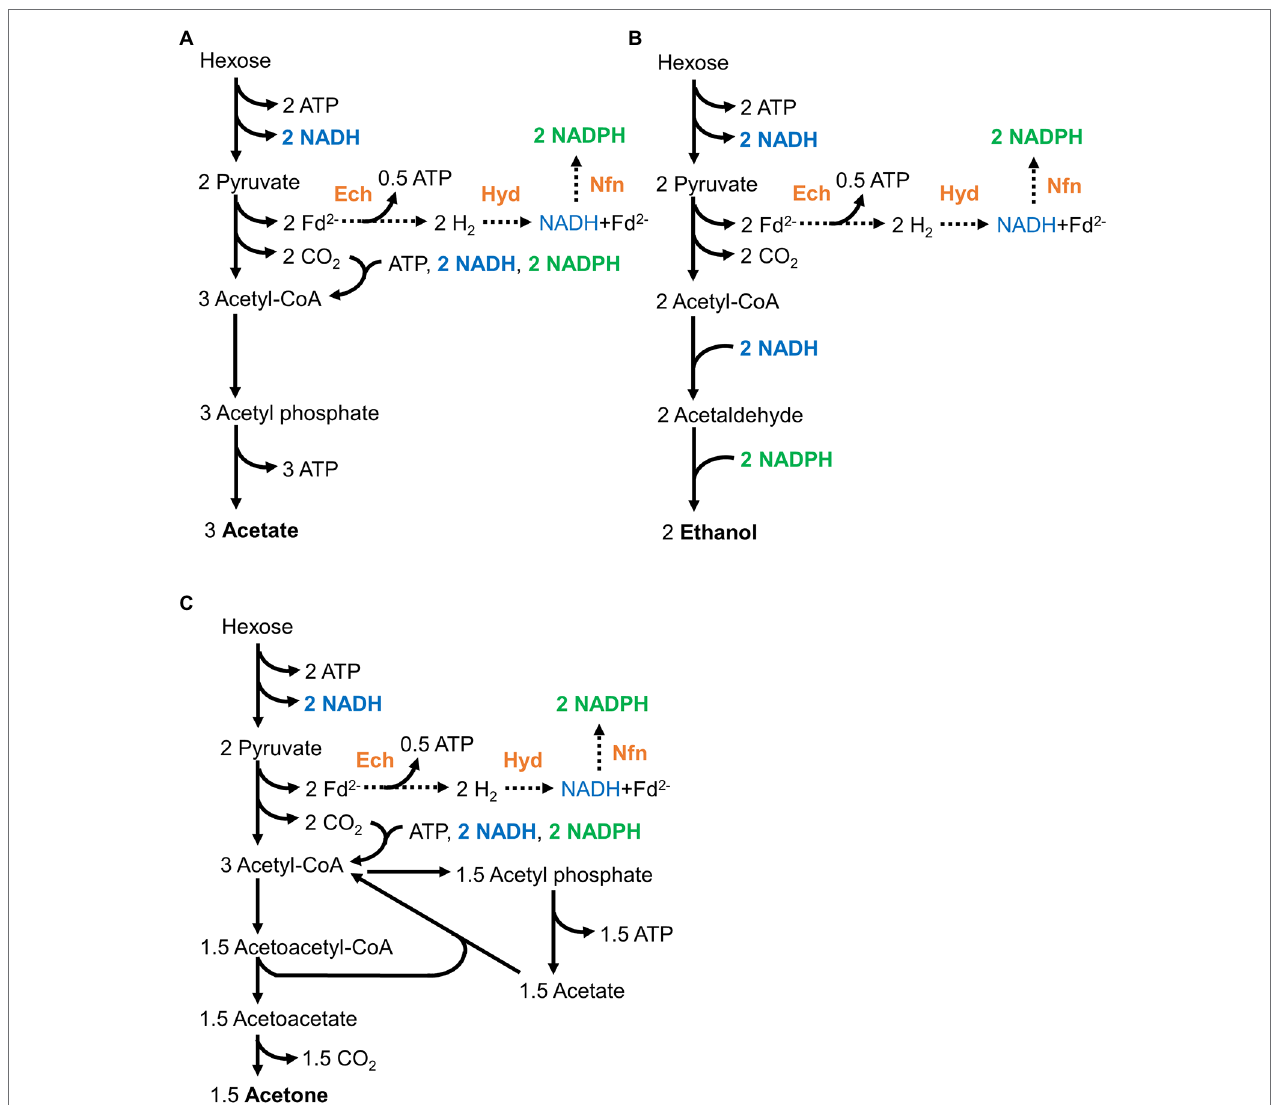
FIGURE 1 | Redox-balanced pathways for acetogenesis (A) , ethanol production (B) , and acetone production (C) from hexose in wild-type and engineered strains for ethanol production. NADH (shown in blue) and the reduced forms of ferredoxin are produced during glycolysis and the conversion of pyruvate to acetyl-CoA. The reduced ferredoxin is converted to NADPH (shown in green) via hydrogenases and electron-bifurcating enzymes, that is, the Ech complex, HydABC, and NfnAB complexes (shown in